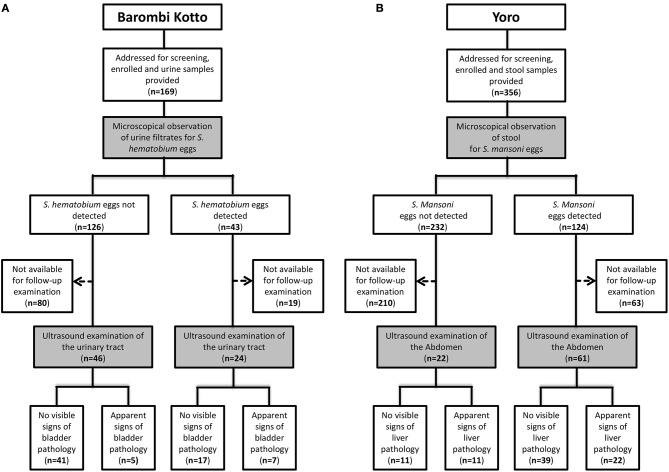
Study flow diagrams. (A). Barombi-Kotto. (B). Yoro.